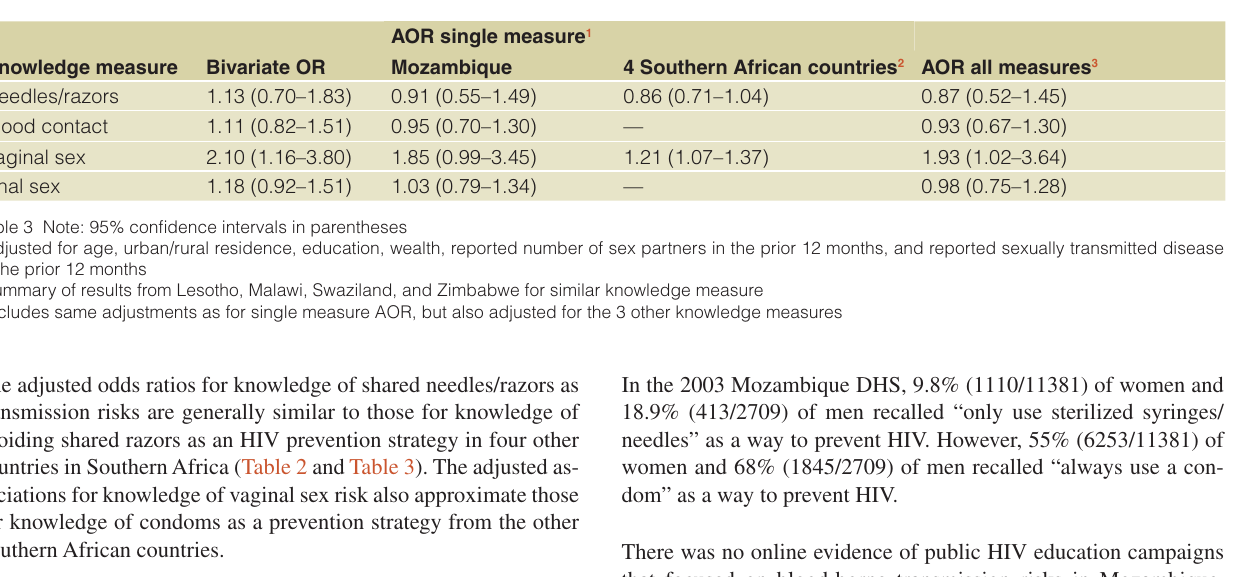
Table 2 Note: 95% confidence intervals in parentheses 1 Adjusted for age, urban/rural residence, education, wealth, reported number of sex partners in the prior 12 months, and reported sexually transmitted disease in the prior 12 months 2 Summary of results from Lesotho, Malawi, Swaziland, and Zimbabwe for similar knowledge measure 3 Includes same adjustments as for single measure AOR, but also adjusted for the 3 other knowledge measures Table 3. Associations between measures of knowledge of HIV transmission modes and prevalent HIV infection, Mozambican men, 2009.